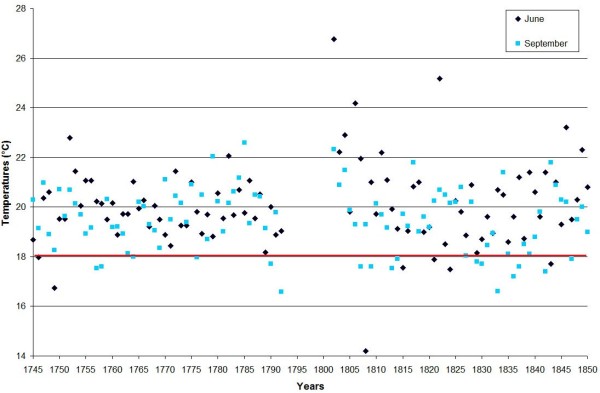
Mean temperatures in June and September at Marseille. The horizontal red line indicates minimal temperature required for P. falciparum (18°C) development.